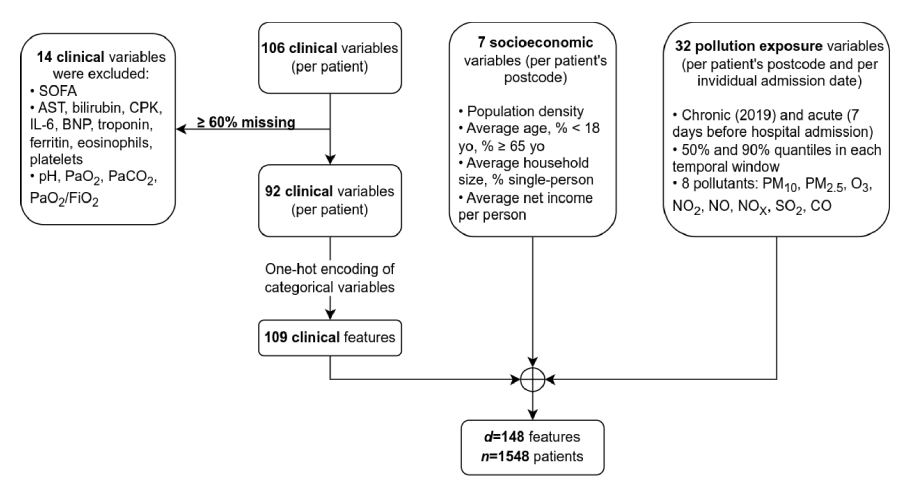
Fig 1. Flow chart for the included and excluded variables, and feature